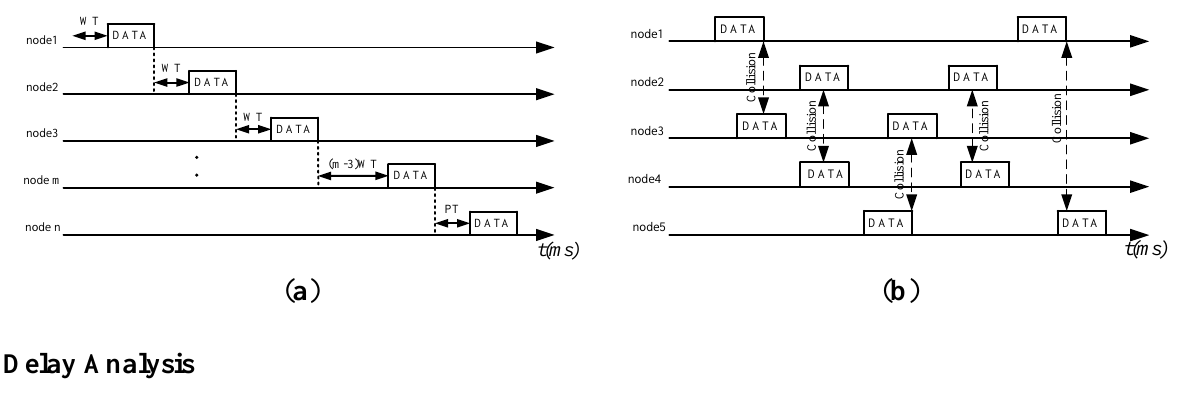
Figure 7. Timing of the algorithms. ( a ) Timing of the ACRA; ( b ) Timing of